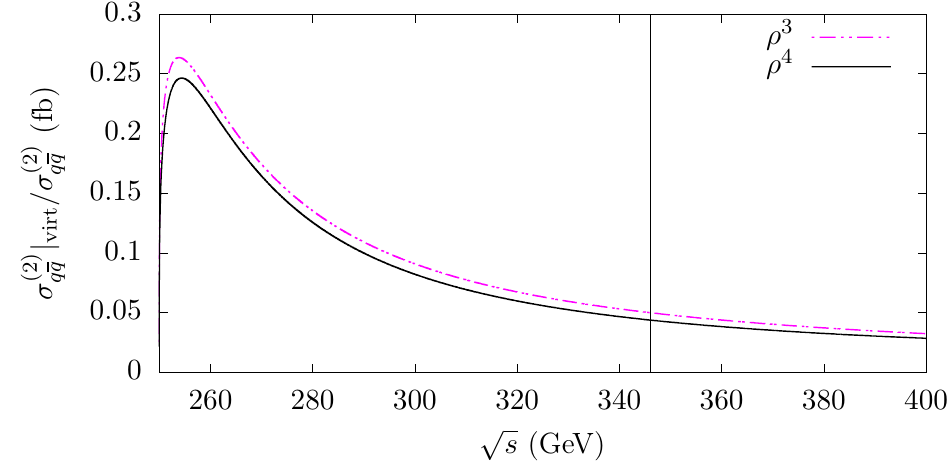
Figure 16 . The ratio between the q ¯ q → HH virtual corrections and the full q ¯ q cross section, as plotted in figure